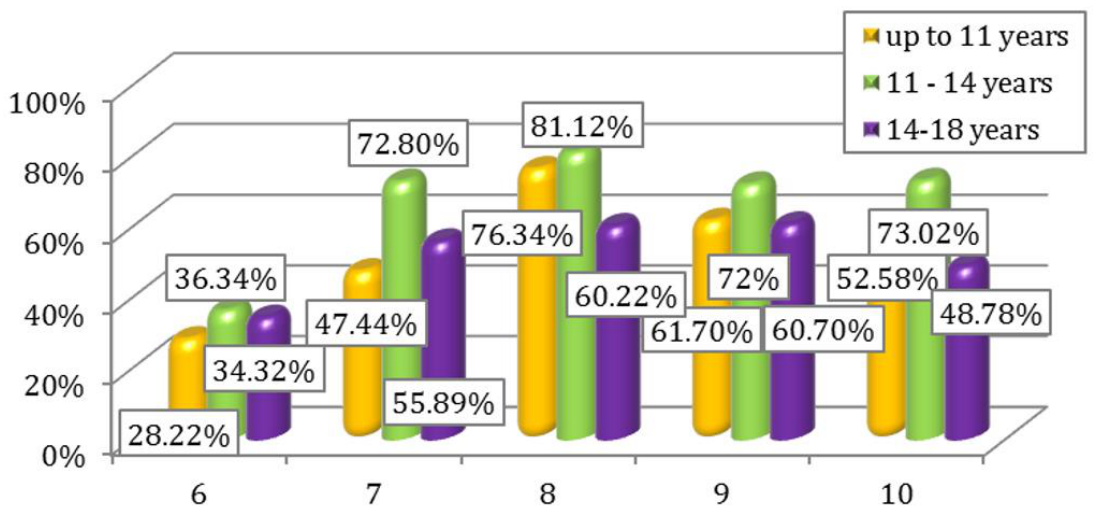
Figure 4. Affirmative answers to questions 6-10 of Questionnaire I according to age.